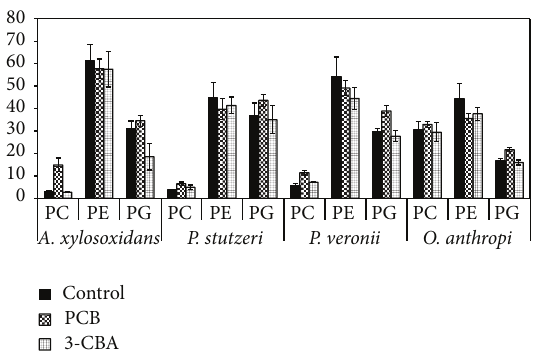
Figure 3: Percentage representation of membrane phospholipids after the addition of nonpolar (PCBs) and polar (3-CBA) toxic pollutants in the presence of four bacterial strains isolated from a long-term PCB-contaminated soil and sediment: Alcali- genes xylosoxidans, Ochrobactrum anthropi, Pseudomonas stutzeri, and Pseudomonas veronii . PC: phosphatidylcholine, PE: phos- phatidylethanolamine, and PG: